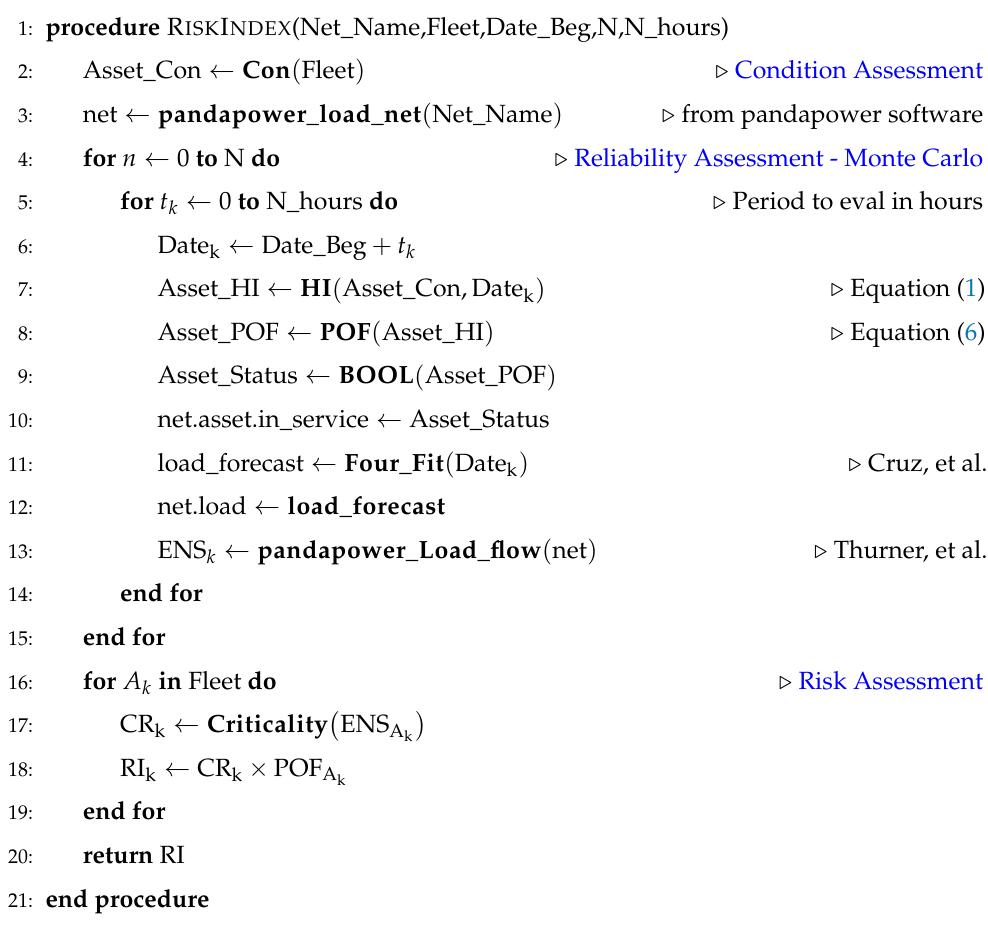
Figure 2. Proposed pseude-algorithm for risk assessment of an electric asset